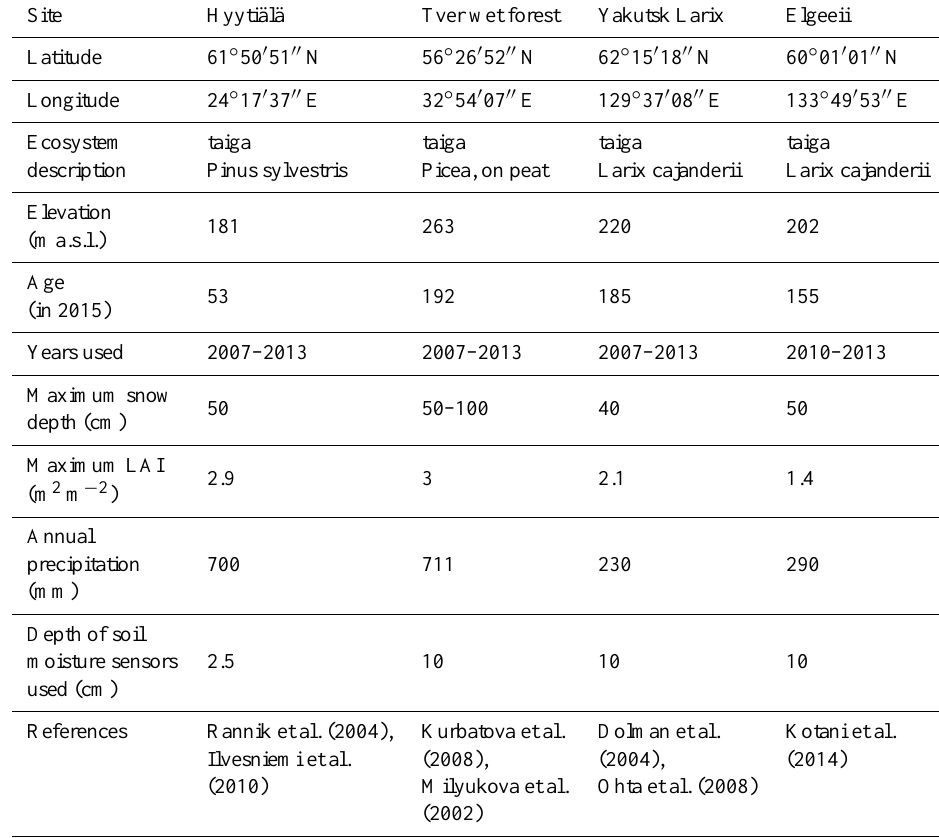
Table 1. Characteristics of the flux tower sites used in this